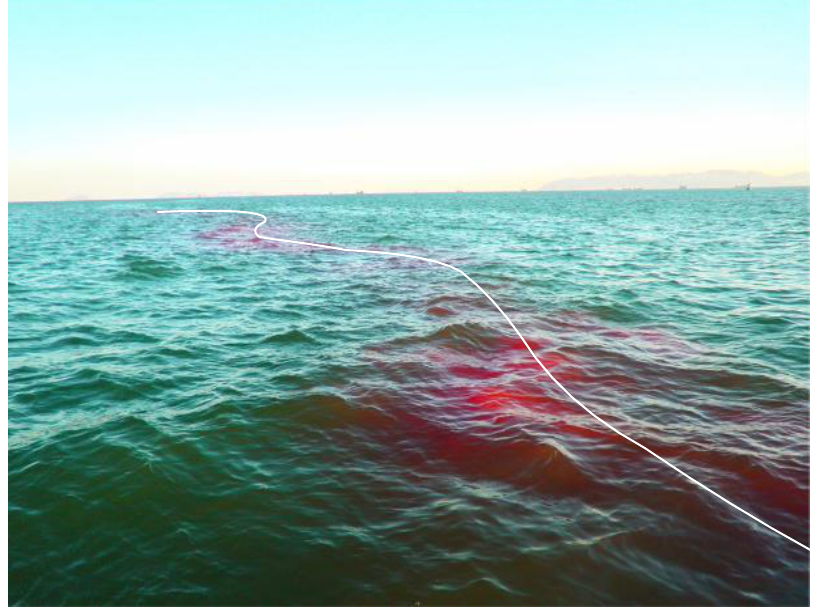
Figure 9. A rhodamine plume generated by a release rate of 1–2 g/min is observed about 350 meters far away from the source. This distance is calculated based on GPS